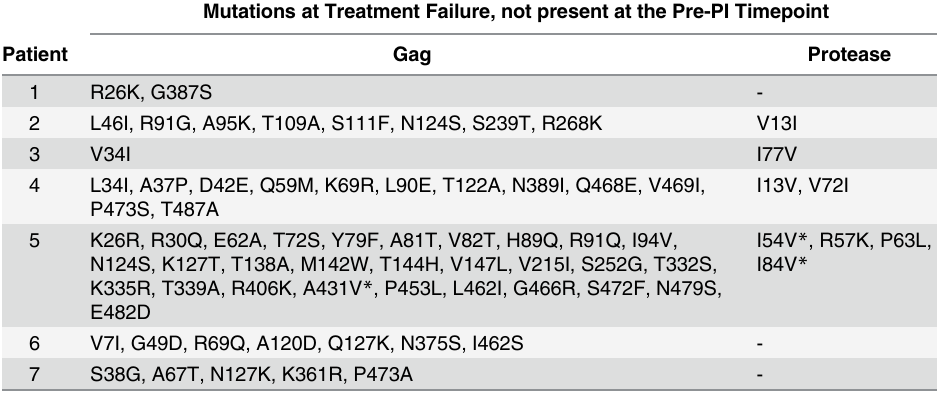
I13V, V72I I54V * , R57K, P63L, I84V *